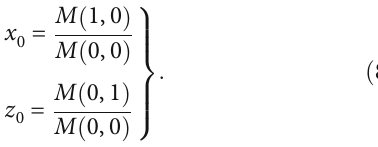
Figure 3: Concentration distributions of the homogeneous case ( k low-/high-permeability regions are marked by the white